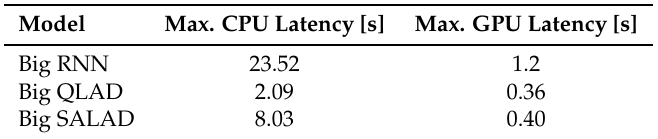
Figure 3. Inference time for the three different studied models: ( Left ) CPU speed curves; and ( Right ) GPU speed curves. Table 4. Maximum inference latency with linear fit for RNN and QLAD models, and quadratic fit for SALAD. All measurements are taken at 45s